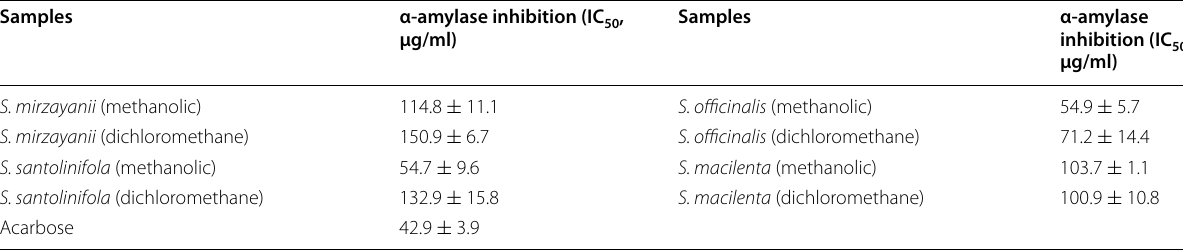
Table 1 IC SD of the extracts and acarbose (μg/ml) 50 ± Samples